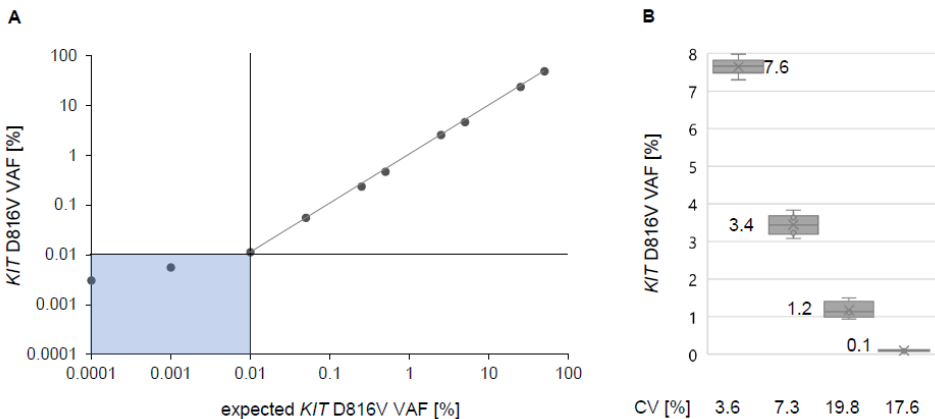
Figure 1. Limit of detection (LOD) and reproducibility of digital PCR (dPCR) for quantitative assessment of the KIT D816V variant allele fraction (VAF). ( A ) dPCR of a dilution series of a patient sample with 50% VAF. Single points represent merged measurements from multiple chips ( n = 3). Dilution results are linear down to 0.1% VAF. ( B ) Reproducibility of four patient samples from 0.1 to 7.6% KIT D816V VAF (measured with at least 3 replicates) showing a coefficient of variation (CV) below 20% for all samples.